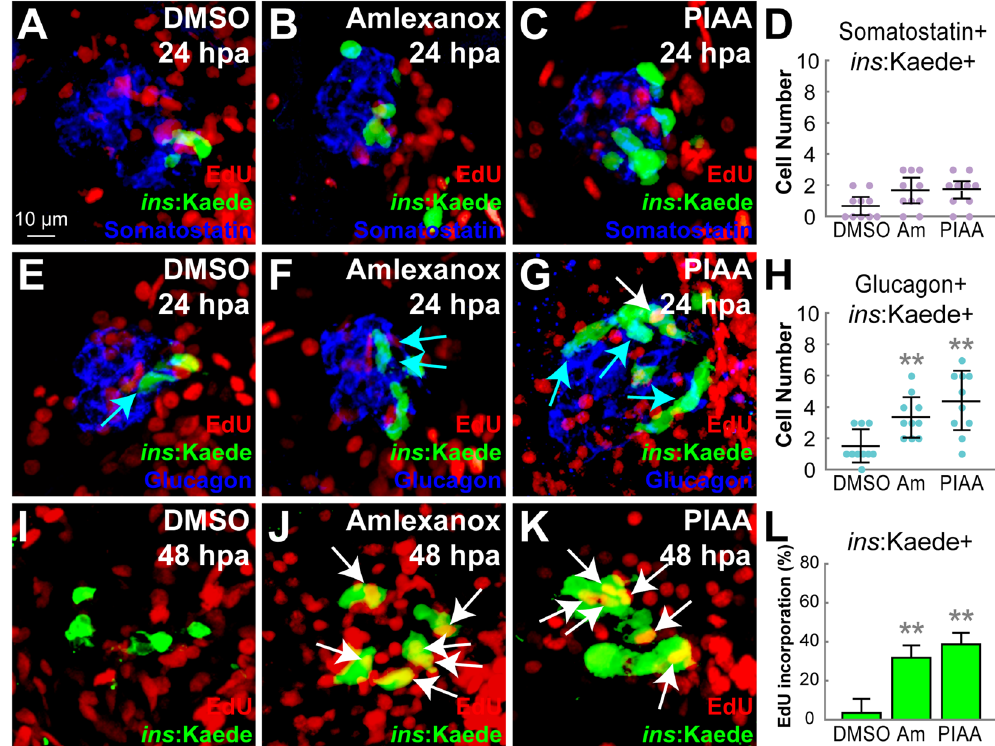
Figure 4. TBK1/IKK ε inhibitors have modest effects on α -to- β -cell transdifferentiation but strongly enhance β -cell proliferation. ( A – C ) Confocal images of [ Tg ( ins : CFP-NTR ) s892 ; Tg ( ins : Kaede ) jh6 ] larvae at 24 hpa, concurrently treated with EdU and DMSO ( A ), amlexanox ( B ), or PIAA ( C ), respectively, from 0–24 hpa, stained for Somatostatin (blue). ( D ) Quantification of the number (mean ± SD) of Insulin and Somatostatin- double positive cells at 24 hpa (in A-C; 0.7 ± 0.6 (DMSO), 1.7 ± 0.8 (amlexanox), and 1.8 ± 0.5 (PIAA)). ( E – G ) Confocal images of [ Tg ( ins : CFP-NTR ) s892 ; Tg ( ins : Kaede ) jh6 ] larvae at 24 hpa, concurrently treated with EdU and DMSO ( E ), amlexanox ( F ), or PIAA ( G ), respectively, from 0–24 hpa, stained for Glucagon (blue). Note that the number of Insulin and Glucagon-double positive cells (blue arrows) was increased in TBK1/IKK ε -I-treated recovering larvae ( F , G ) compared to DMSO-treated larvae ( E ). PIAA-treated larvae also showed an EdU- incorporated β -cell (white arrow) ( G ). ( H ) Quantification of the number (mean ± SD) of Insulin and Glucagon- double positive cells at 24 hpa (in E-G; 1.5 ± 1.1 (DMSO), 3.4 ± 1.3 (amlexanox), and 4.4 ± 1.9 (PIAA)). ( I – K ) Confocal images of [ Tg ( ins : CFP-NTR ) s892 ; Tg ( ins : Kaede ) jh6 ] larvae at 48 hpa, concurrently treated with EdU and DMSO ( I ), amlexanox ( J ), or PIAA ( K ), respectively, from 24–48 hpa. The number of β -cells that incorporated EdU (white arrows) was significantly increased in TBK1/IKK ε -I-treated recovering larvae ( J , K ) compared to DMSO-treated larvae ( I ). ( L ) The percentage (mean ± SD) of regenerated β -cells that incorporated EdU at 48 hpa (in I-K; 4.0 ± 7.0% (DMSO), 32.0 ± 6.0% (amlexanox), and 39.0 ± 6.0% (PIAA)). Cells in 20 planes of confocal images from 10 individual larvae were counted per condition. ** P <